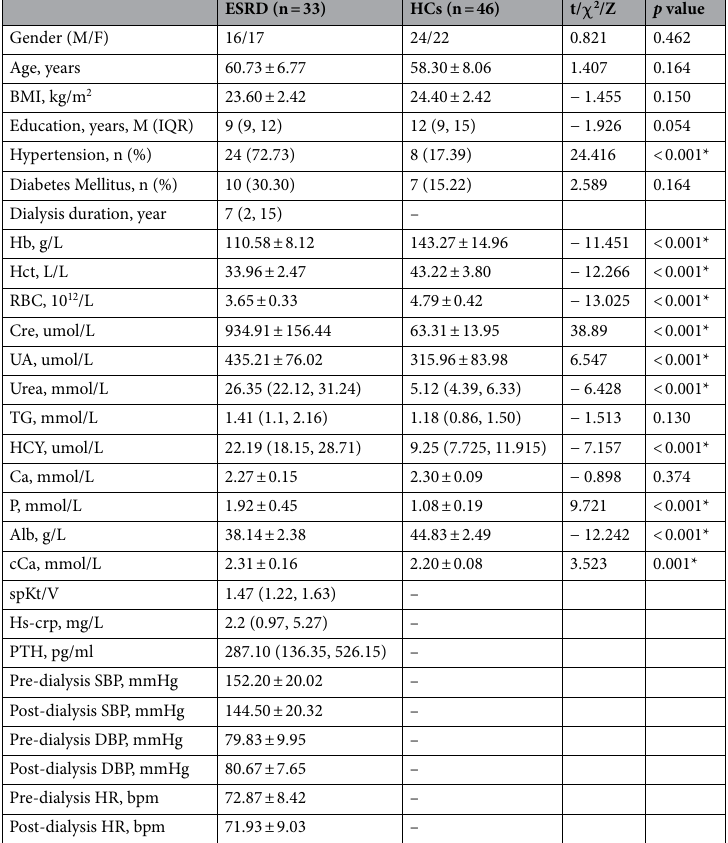
Table 1. Demographic and clinical characteristics. HC health controls, ESRD end stage renal disease, BMI body mass index, Hb hemoglobin, Hct hematocrit, RBC red blood cell, Cre creatinine, UA uric acid,